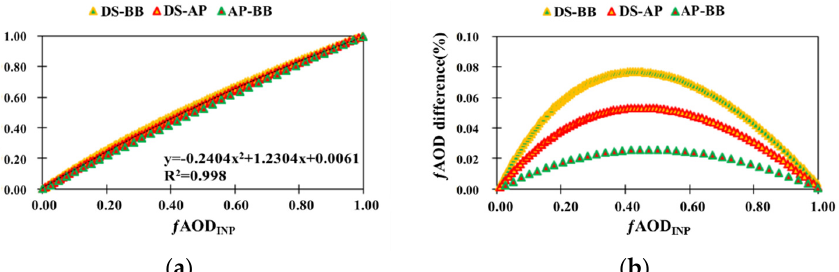
Figure 8. ( a ) The comparison of the derived f AOD from the NDAI approach ( f AOD NDAI ) with the input mixing weight of the simulation (with f AOD INP as the reference). The yellow triangles denote that the AOD fraction of BB in DS–BB mixtures increased from 0.0 to 1.0 along the X–axis, while AOD fraction of DS decreased from 1.0 to 0.0 accordingly. The same illustrations are displayed for the mixtures of DS–AP (red triangles) and AP–BB (green triangles). ( b ) The difference between f AOD NDAI and f AOD INP is shown as a percentage.